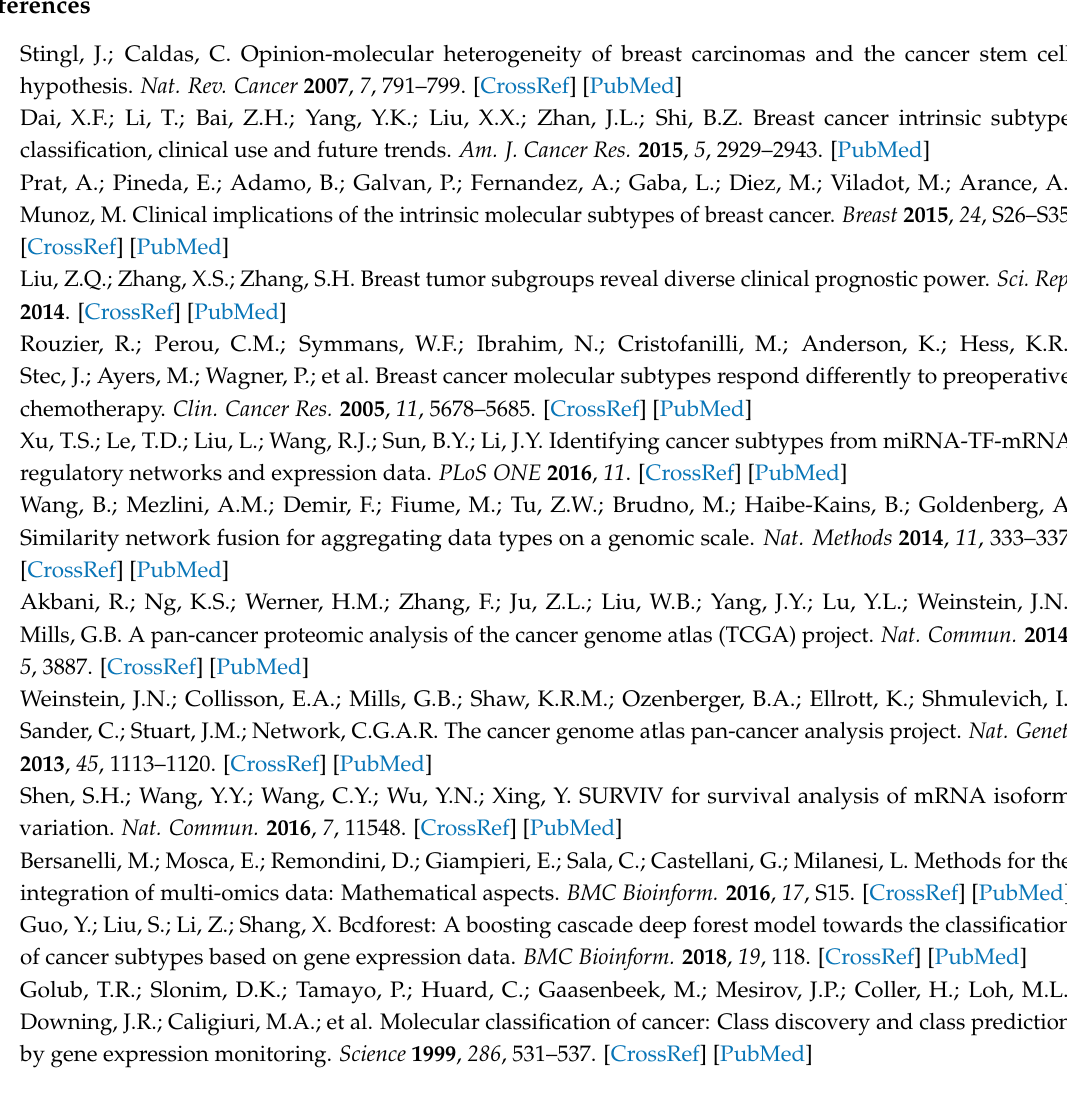
Figure S1: The identified subtypes in LSCC cancer datasets, Figure S2: The identified subtypes in COAD cancer datasets, Table S1: GO enrichment analysis of differentially expressed genes between subtypes 1 and 2 in GBM cancer datasets, Table S2: GO enrichment analysis of differentially expressed genes between subtypes 1 and 3 in GBM cancer